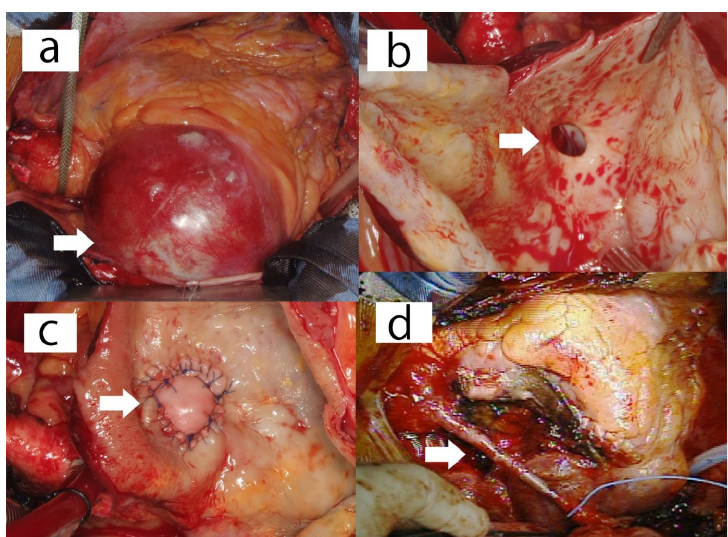
Fig. 2 - Operative findings. a) Right super-giant coronary artery aneurysm (CAA) at the aortic root, displacing the right atrium (arrow). b) The right super-giant CAA is cut open. An enlarged right coronary ostium (8 mm) is observed at the bottom of the aneurysm (arrow). Communication to the distal coronary artery is not observed. c) The right coronary ostium is closed by interleaving the aortic wall around the ostium with two bovine pericardial patches (arrow).